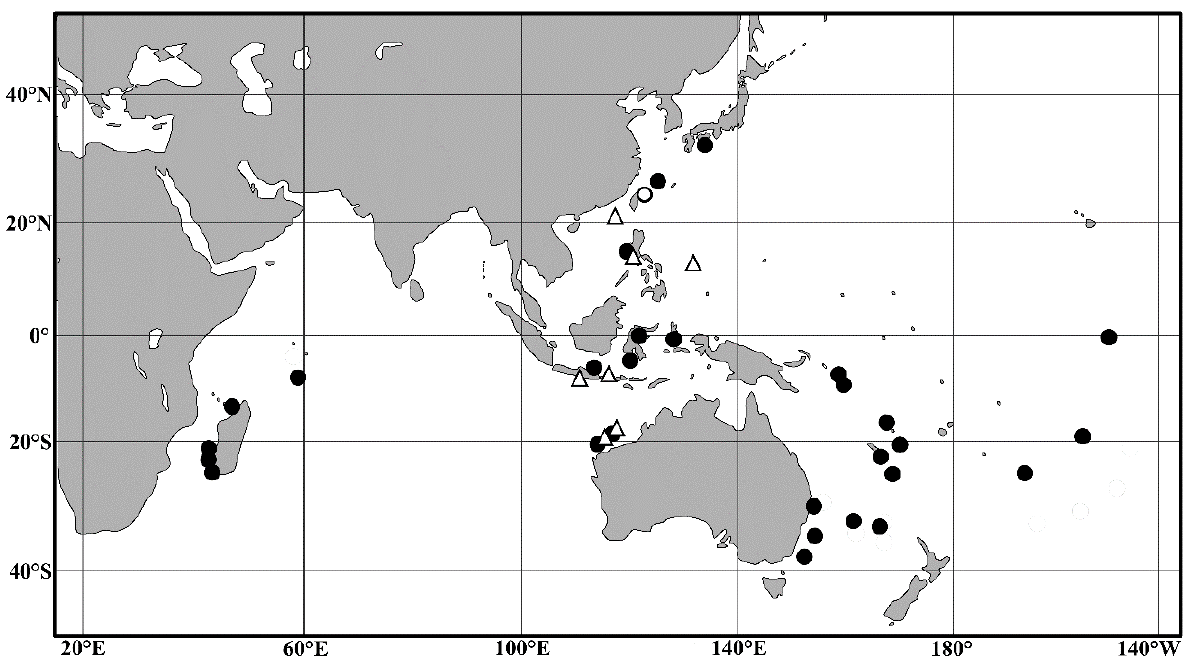
Figure 33. Distribution map of H. simula (open triangles), H. stellifera (black dots), and H. taiwanea